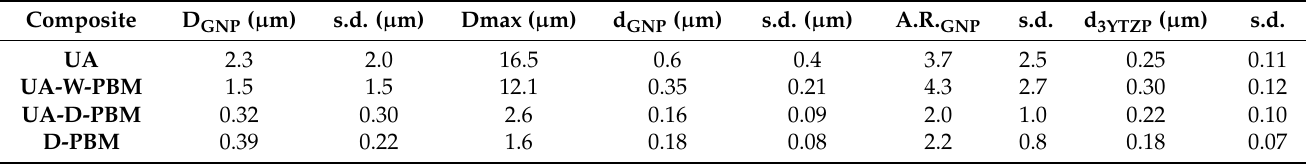
each composite. Table 1. Morphological parameters of the GNP and grain size of the 3YTZP ceramic matrix measured for each composite [33]. The first column indicates the different powder processing techniques described in the experimental part: (i) UA: wet powder mixing by ultrasonic agitation, (ii) UA-W-PBM: wet powder mixing by ultrasonic agitation followed by wet planetary ball milling, (iii) UA-D-PBM: wet powder mixing by ultrasonic agitation followed by dry planetary ball milling and (iv) D-PBM: dry powder mixing by planetary ball